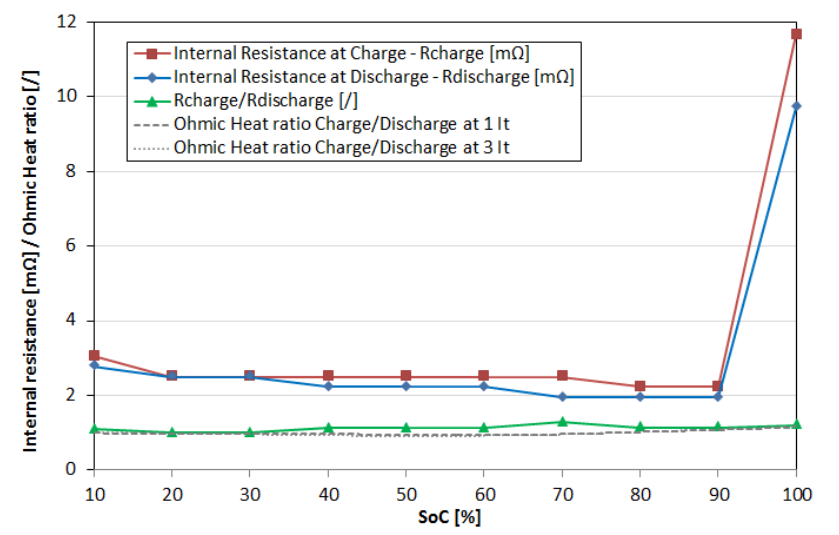
Figure 9. Internal resistance during charge and discharge